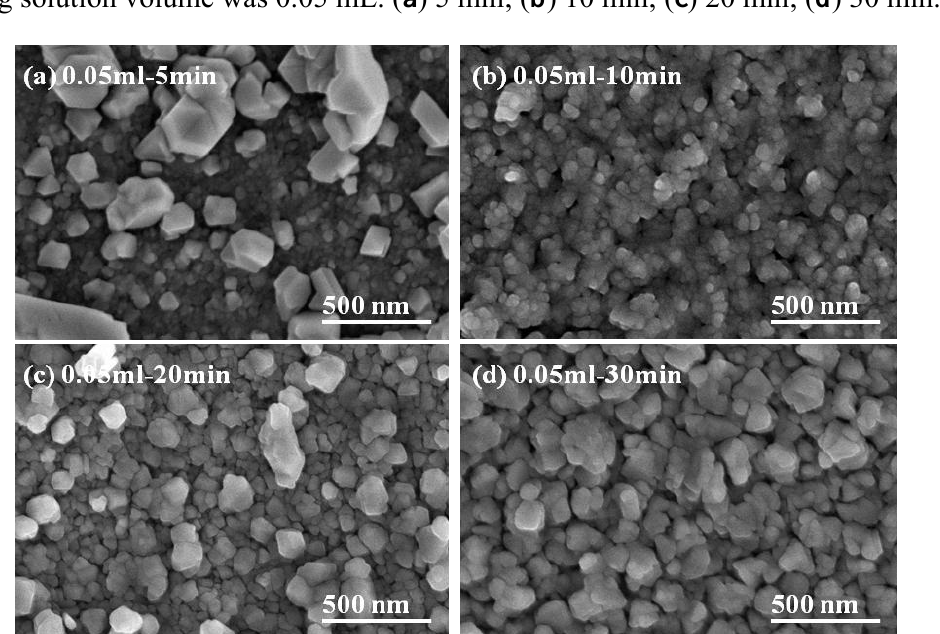
Figure 5. Surface morphologies of the CIS absorber layers as a function of annealing time, the using solution volume was 0.05 mL. ( a ) 5 min; ( b ) 10 min; ( c ) 20 min; ( d ) 30 min.